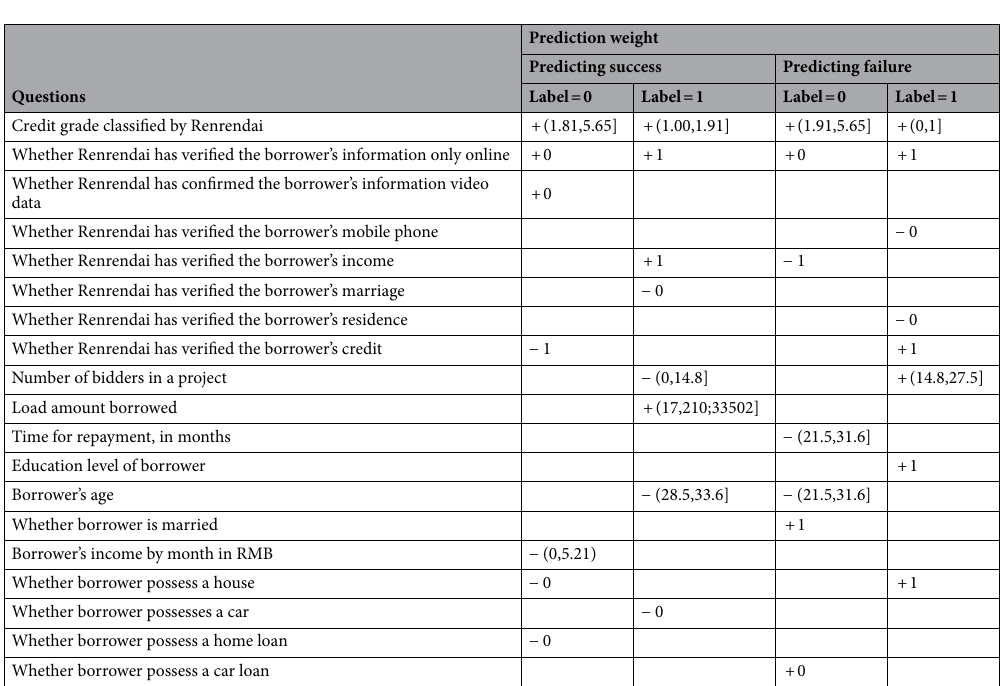
Table 6. Variable weights of the XGBT model. Label = 0 means Repayments Success. Label = 1 means Repayments Failure. ‘+’ means Supports, ‘−’ means